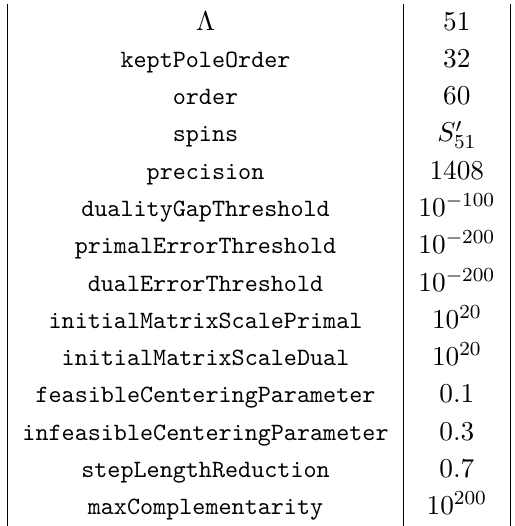
Table 3 . Parameters used for the computations of the OPE coefficient bounds. The set S 0 by S 0 = { 0 , . . . , 44 } ∪ { 47 , 48 , 51 , 52 , 55 , 56 , 59 , 60 , 63 , 64 , 67 , 68 } 51